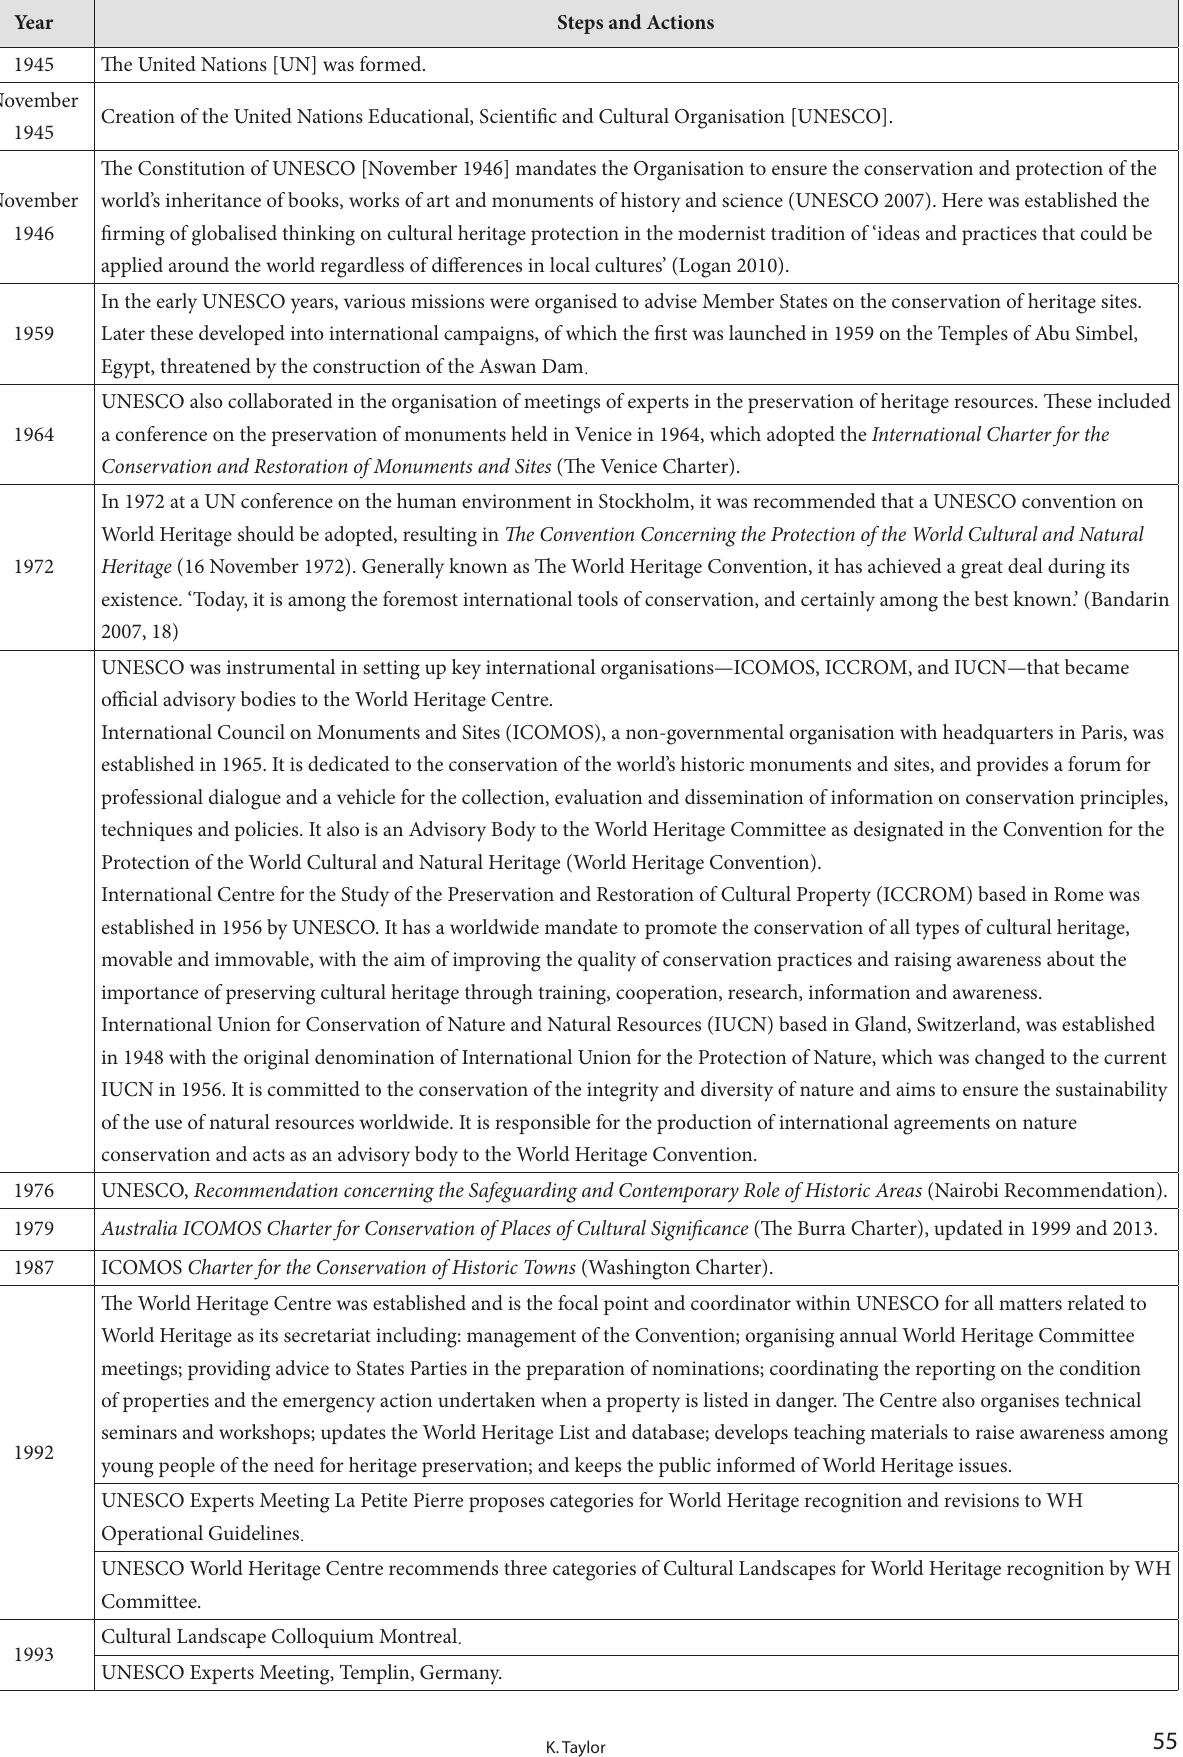
Table 1 Chronology of steps and actions in development of the heritage process (Source: the